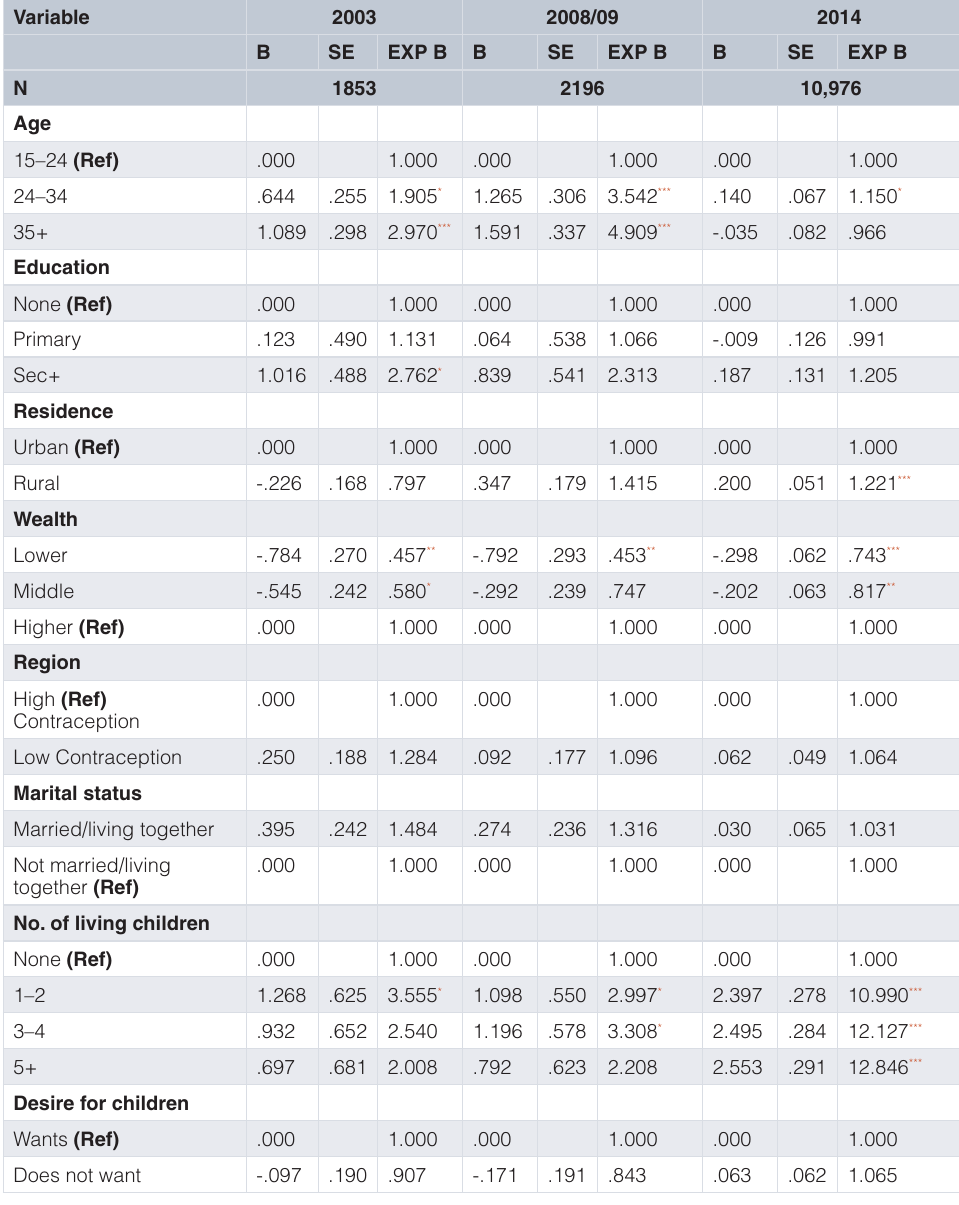
Table 2. Logistic regression results for LARC use for all women of reproductive age in Kenya